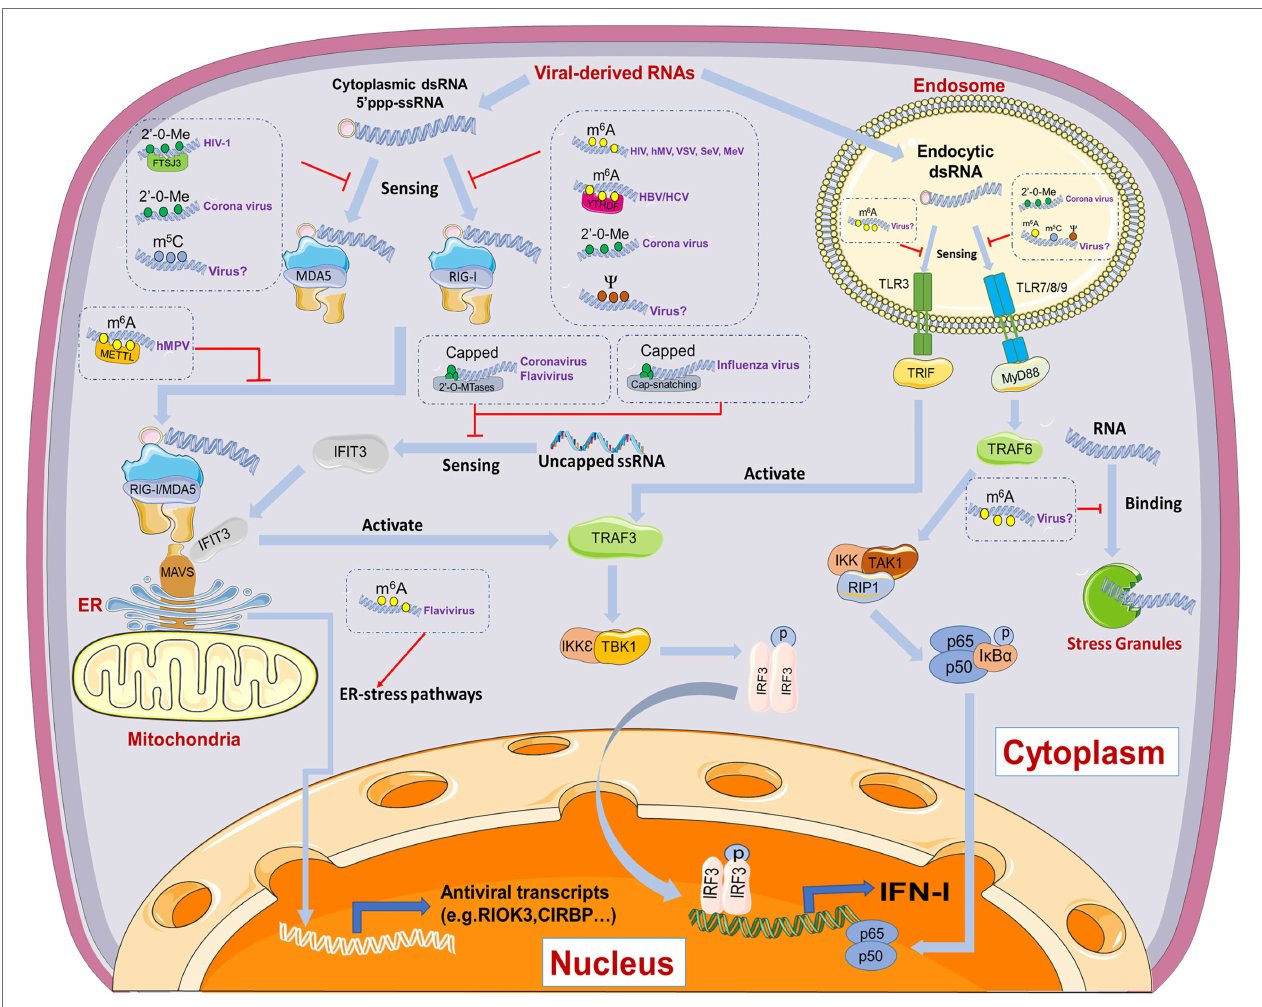
FIGURE 2 | Schematic diagram of mechanisms by which RNA modification regulating viral-derived RNA recognition and innate immune responses. N 6 -methyladenosine (m 6 A), 5-methylcytidine (m 5 C), 2 ʹ -O-methylation (2 ʹ -O-Me), and pseudouridine ( ψ ) are demonstrated to inhibit melanoma differentiation-associated protein 5 (MDA5) or retinoic acid-inducible gene I (RIG-I) mediated sensing. METTL and YTHDF proteins are involved in these process. Inside the endosomes, 2 ′ -O-Me are identified to block the TLR7-dependent type I interferon (IFN-I) response. Meanwhile, m 6 A, m 5 C, and ψ also prevent the Toll-like receptors (TLRs) activation inside the endosomes, although the relevance to virus infection still remains ambiguous. Moreover, m 6 A may regulate antiviral innate immunity through stress granules or endoplasmic reticulum (ER)-stress pathways, the latter of which has already been illustrated in Flavivirus